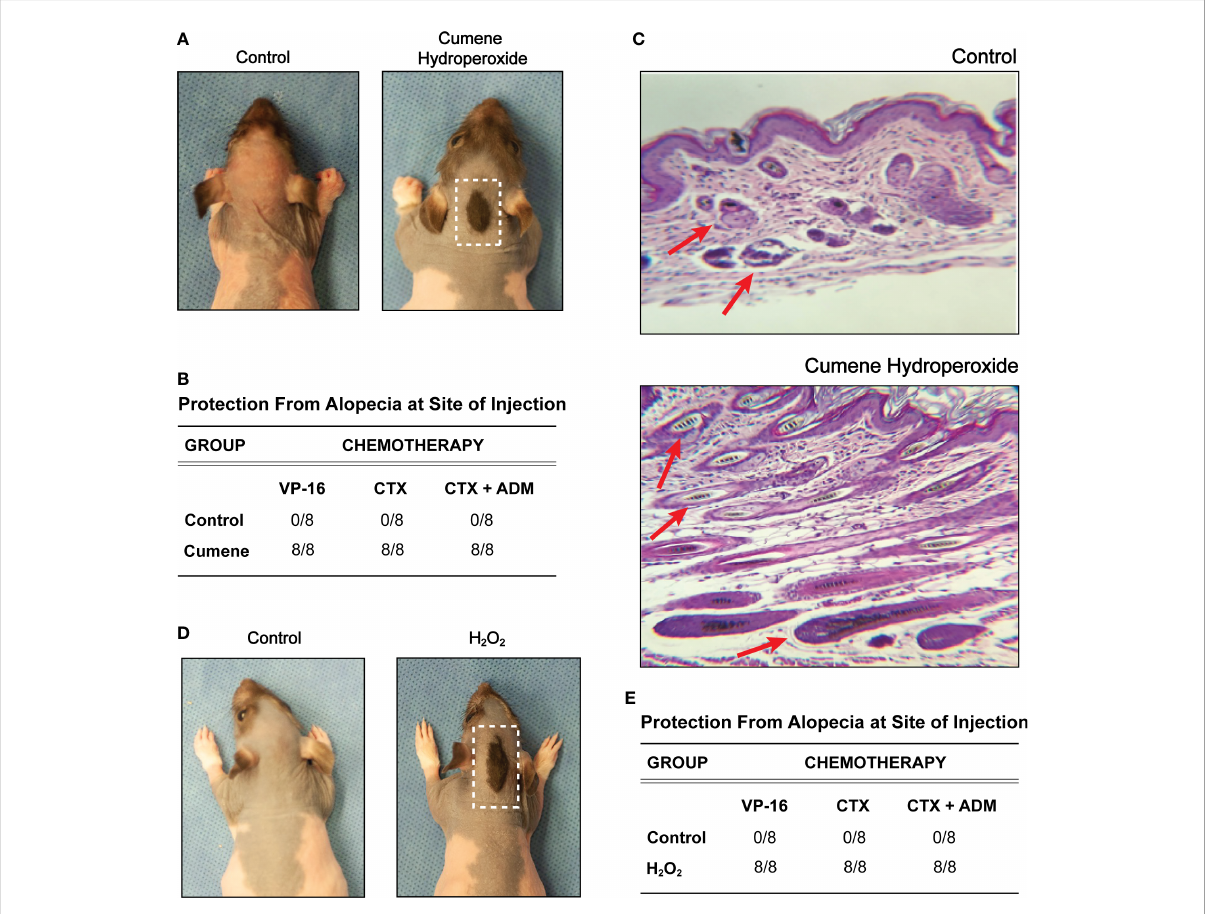
FIGURE 1 Pre-treatment with cumene hydroperoxide prevents chemotherapy-induced alopecia. (A) Representative photographic images of VP16-induced alopecia in control rats (left) and rats pre-treated with cumene hydroperoxide. The scalp area with a preserved coat of hair demarks the site of cumene hydroperoxide injection and is outline in white. (B) Table compilation of alopecia protection at the injection site in control rats and rats pre-treated with cumene hydroperoxide after completing a course of Etoposide (VP-16), Cytoxan (CTX), or Cytoxan-Adriamycin (CTX-ADM) treatment. N = 8 per treatment group. (C) Representative light microscopic sections of skin biopsy obtained from control rats and cumene hydroperoxide treated rats (bottom) seven days post chemotherapy. Slides were stained with hemotoxylin and eosin. Red arrows denote representative hair follicles that are damaged (above) and healthy (below). (D) Representative photographic images of VP16-induced alopecia in control rats (left) and rats pre-treated with hydrogen peroxide (H 2 O 2 ). The scalp area with a preserved coat of hair demarks the site of H 2 O 2 injection and is outlined in white. (E) Table compilation of alopecia protection at the injection site in control rats and rats pre-treated with H 2 O 2 after completing a course of Etoposide (VP-16), Cytoxan (CTX), or Cytoxan-Adriamycin (CTX-ADM) treatment. N = 8 per treatment